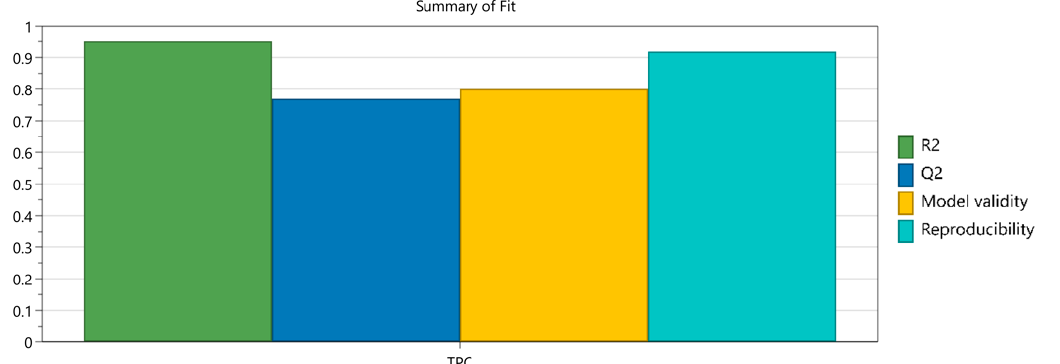
Figure 1. Summary of fit for DoE model.